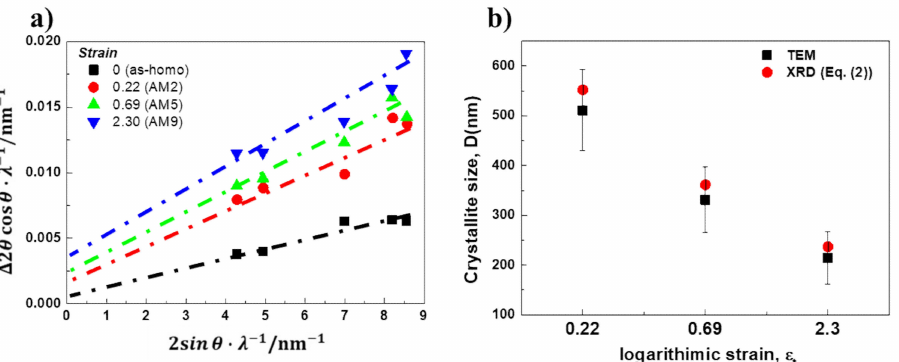
Figure 9. ( a ) Williamson-Hall plots and ( b ) Crystallite size of the cold-rolled AA3003 aluminum alloy measured by XRD and